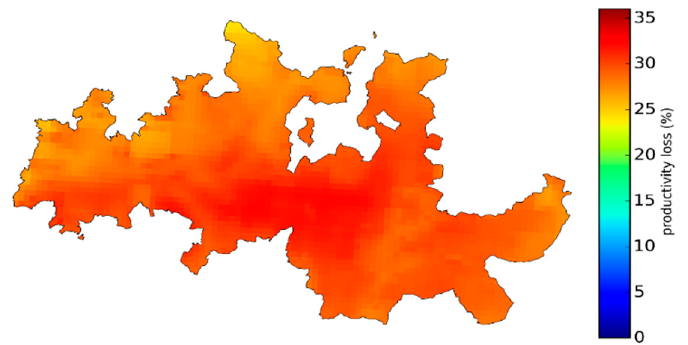
Figure 9. Productivity loss (%) in DDR (D04, 1 × 1 km 2 horizontal resolution), averaged for the 3 simulation years and based on Soja et al. (2004) exposure–response functions.